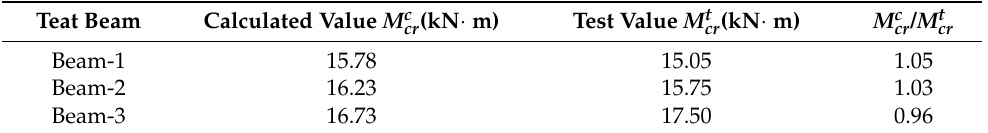
Table 4. Calculated and test values of the cracking moment.